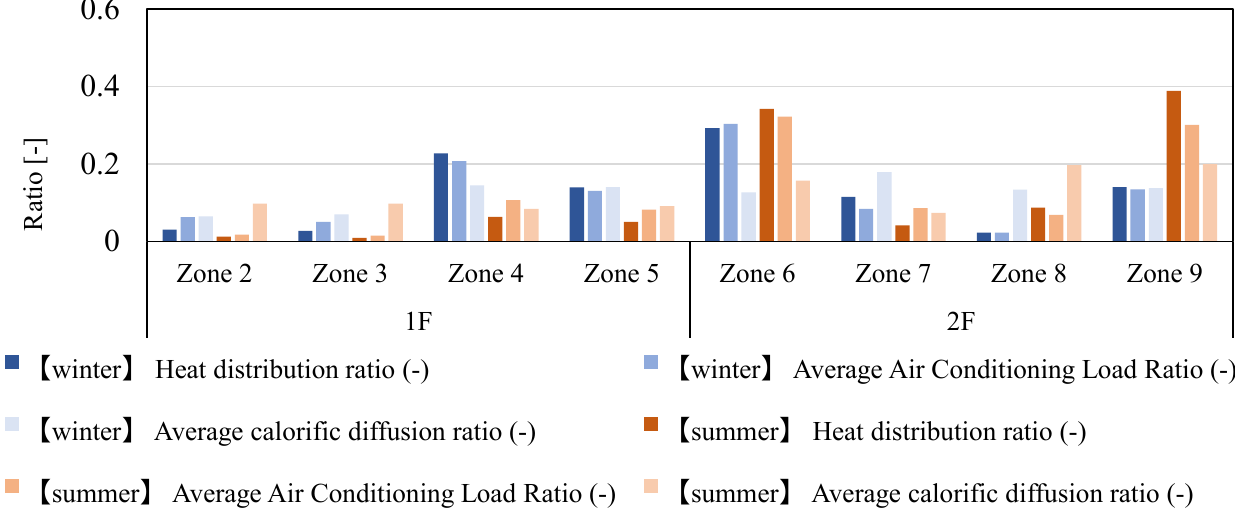
Figure 5. Calorimetric diffusivity and ratios used in calculations. 1F, first floor; 2F, second floor.